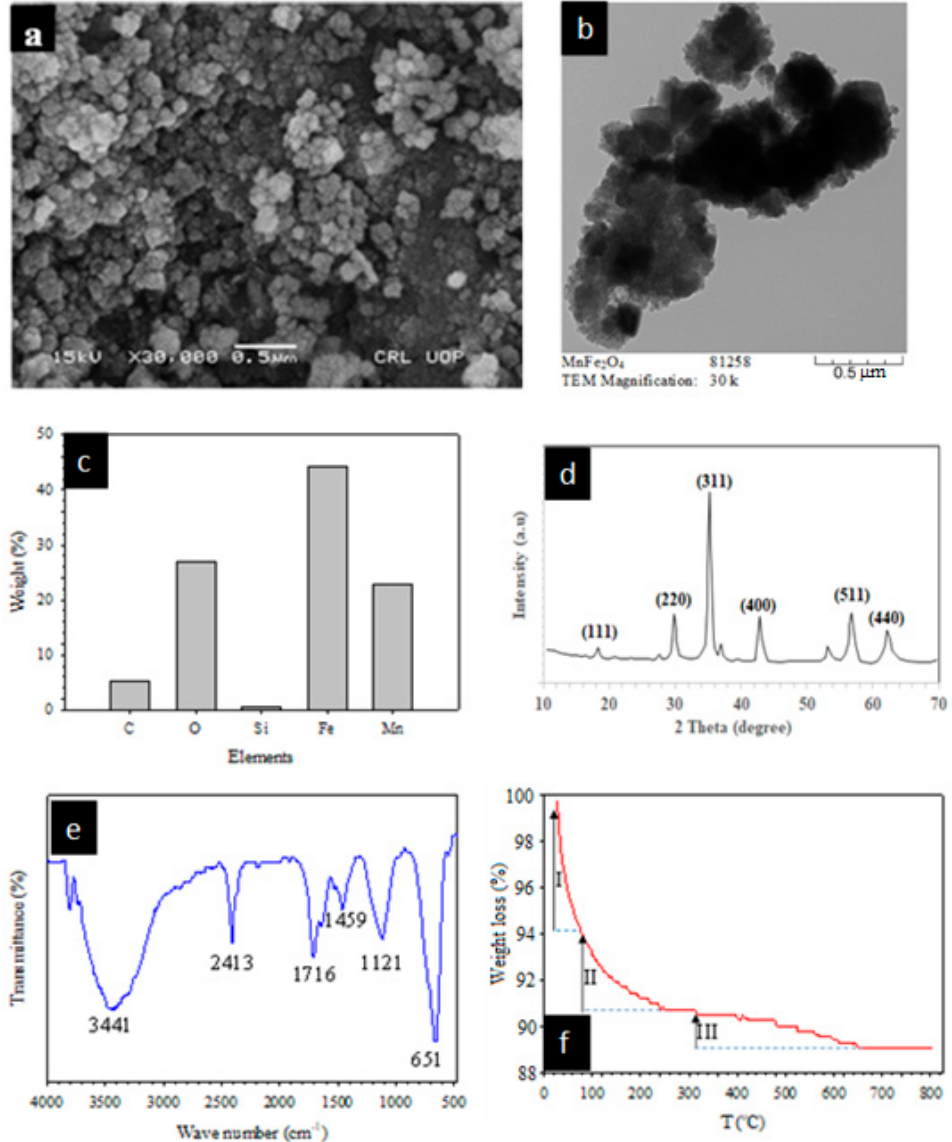
Figure 1. Physical characterization ( a ) Scanning Electron Microscopy (SEM), ( b ) Transmission Electron Microscopy (TEM), ( c ) Energy Dispersive X-ray Spectroscopy (EDX), ( d ) XRD pattern, ( e ) Fourier Transform Infrared Spectrometer (FT-IR) spectrum and ( f ) Thermal Gravimetric Analyzer (TGA) analysis of MnFe 2 O 4 .